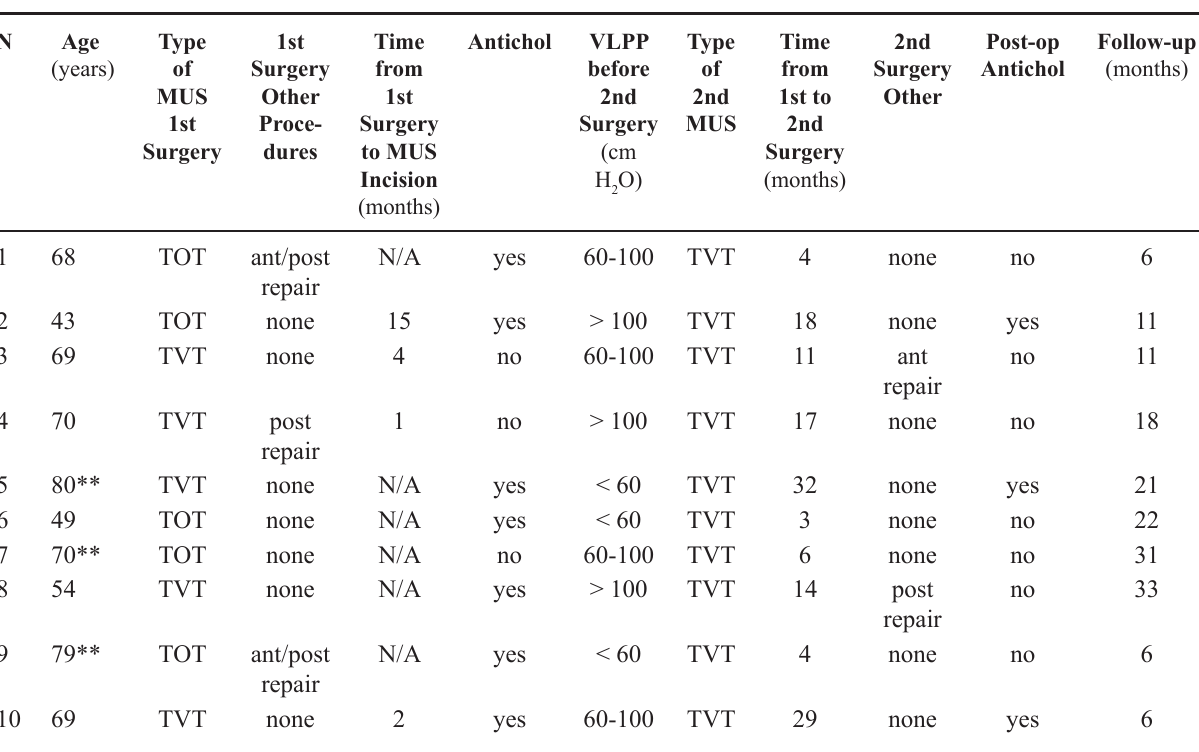
Table 1 – Patient